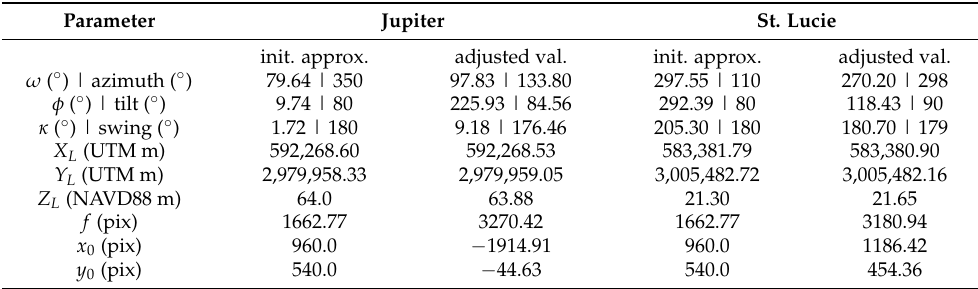
Figure 3. Reprojection residuals at the St. Lucie ( a ) and Jupiter ( b ) cameras atop geo-rectified images. Insets show ( left ) a boxplot of reprojection residuals in meters, where the box extends from the 25th to 75th percentiles, whiskers extend to the range (excluding outliers, x-marks), and line represents the median; and (right) a scatter plot of north-south vs. east-west residual components (absolute value) in meters, where the black line is the 1:1 line. Table 1. Initial approximations and final adjusted values of the nine parameters included in the camera calibrations.